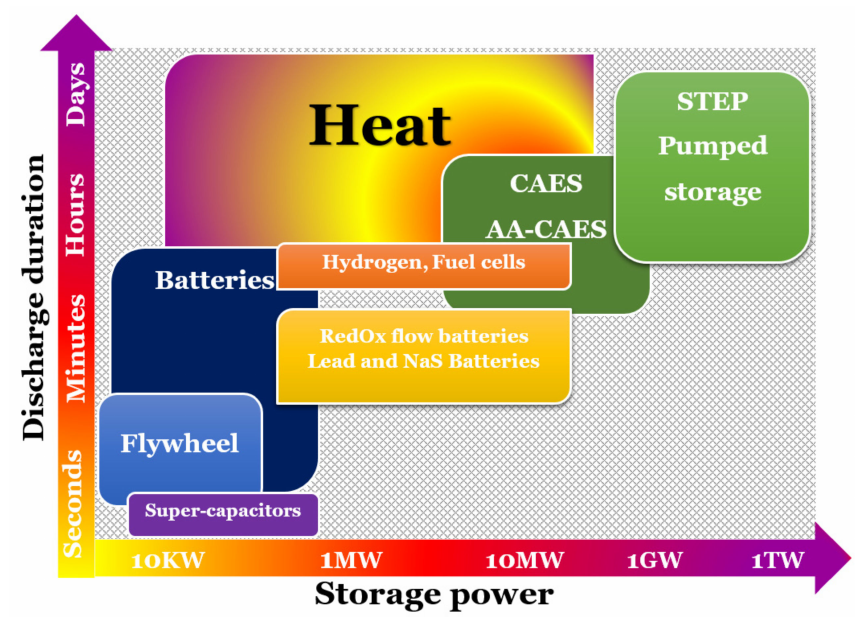
Figure 1. Different storage technologies depending on their storage power and discharge time.